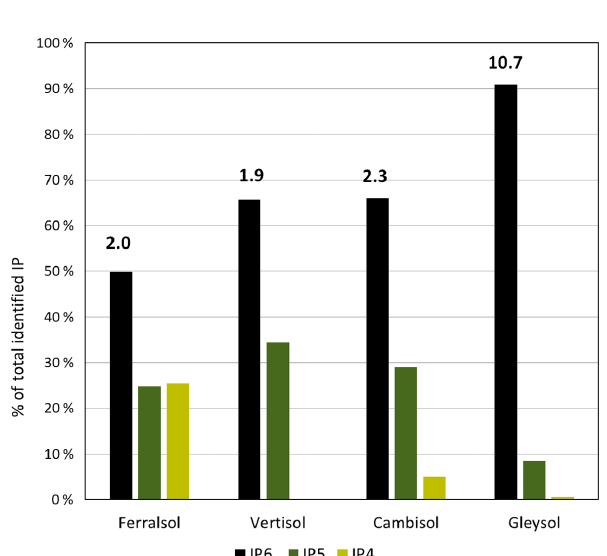
Figure 2. The proportion of total identifiable pools of inositol hexakisphosphates (IP 6 ), pentakisphosphates (IP 5 ) or tetrakispho- sphates (IP 4 ) in the total pool of identifiable IP, as determined by solution 31 P NMR spectroscopy on four soil extracts (Ferralsol, Vertisol, Cambisol and Gleysol) following hypobromite oxidation. Values located above the IP 6 bar are the ratio of total identifiable IP 6 to total identifiable IP 5 in each soil